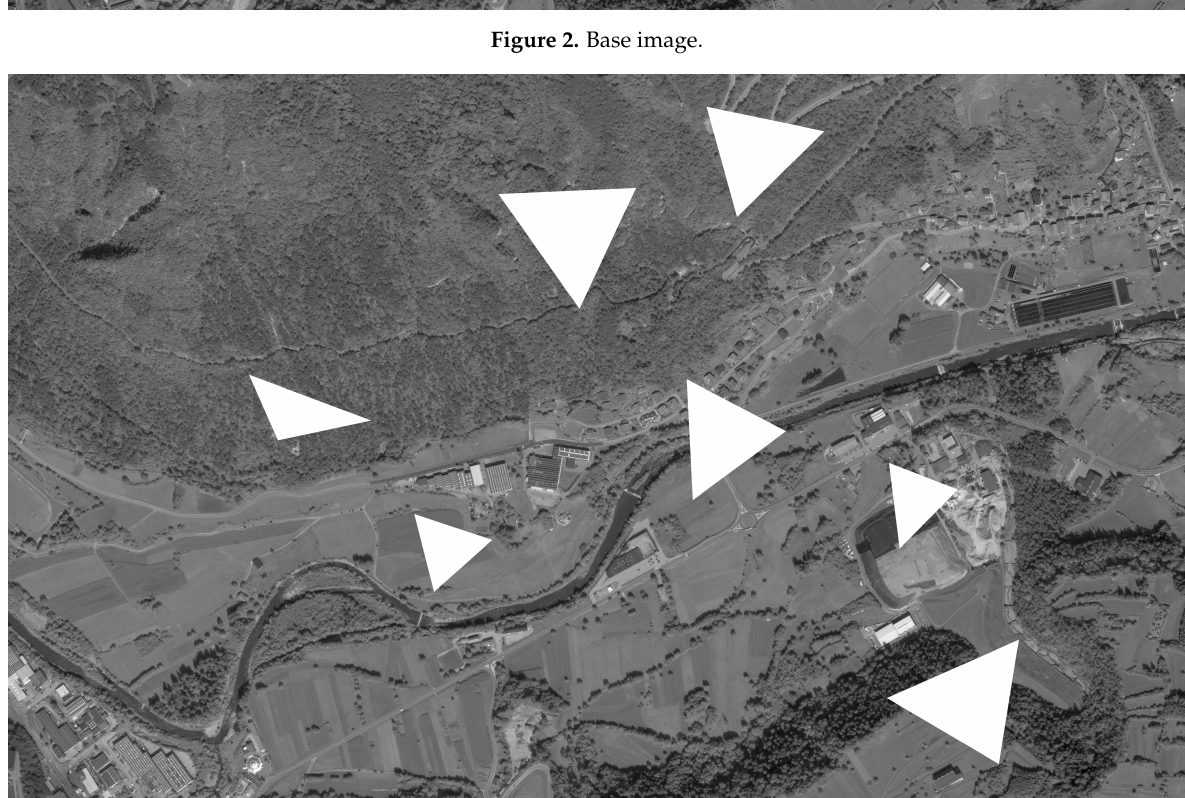
Figure 3. Target